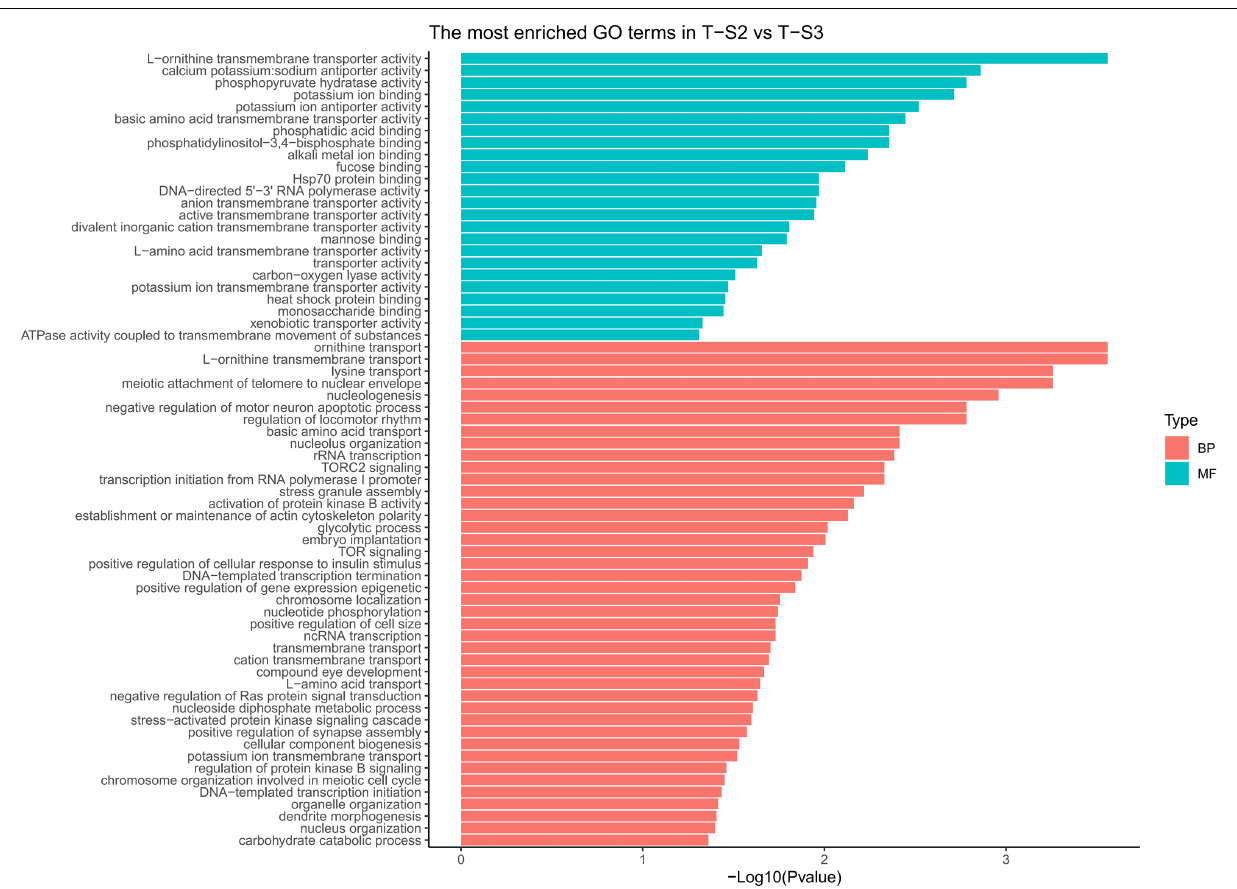
FIGURE 6 | Histograms of the enriched biological processes (BP) and molecular functions (MF) from the genes with differentially methylated positions in individuals from the depth treatment samplings in T-S2 vs. T-S3 (T-S2, T-S3 = depth treatment at sampling times 2 and 3, respectively).